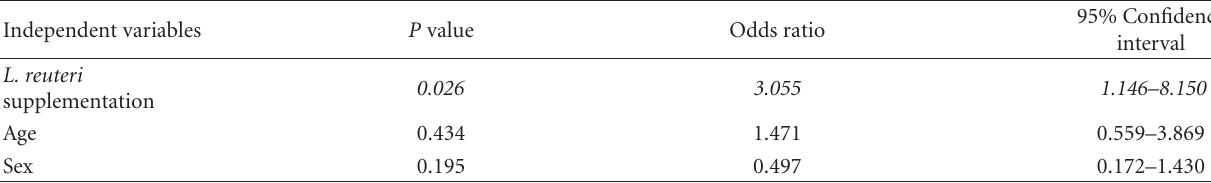
Table 2: HP-eradication: multivariate